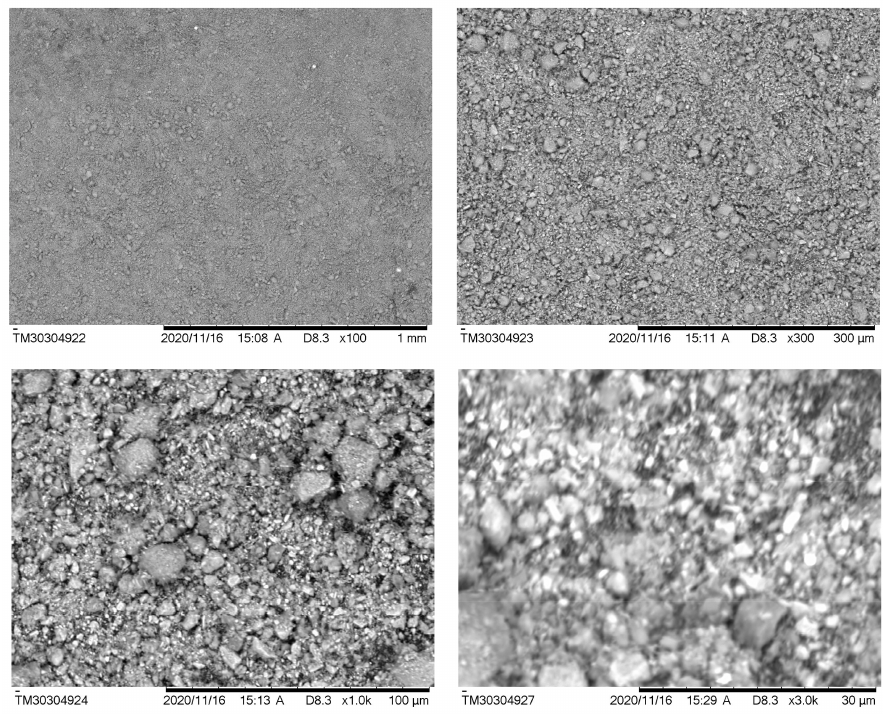
Figure 3. Electronic micrographs of the samples of manganese ore from the Bogach deposit.